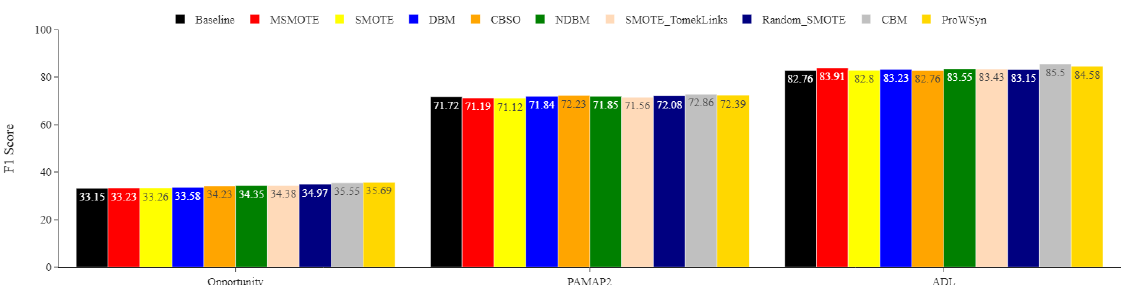
Figure A1. F 1 score of baseline (SVM), the proposed method, and the sampling methods for the Opportunity, PAMAP2, and ADL datasets. The reported means of F 1 scores were obtained from 30 repetitions.